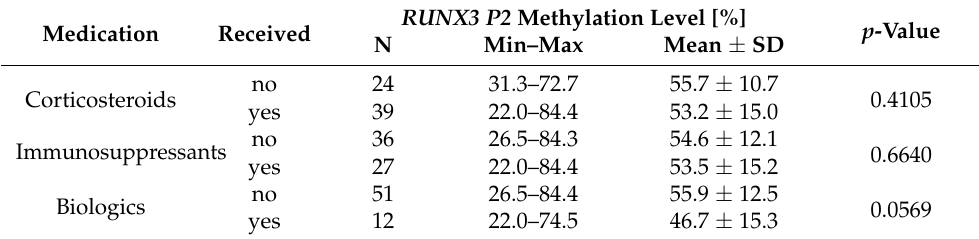
Table 3. Methylation of RUNX3 vs. applied